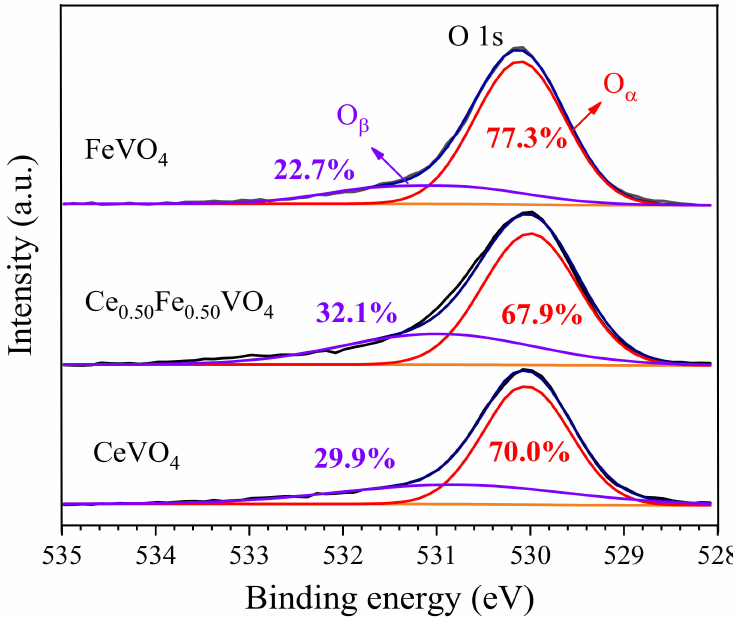
Figure 9. O 1s XPS spectra of CeVO 4 , Ce 0.50 Fe 0.50 VO 4 , and FeVO 4